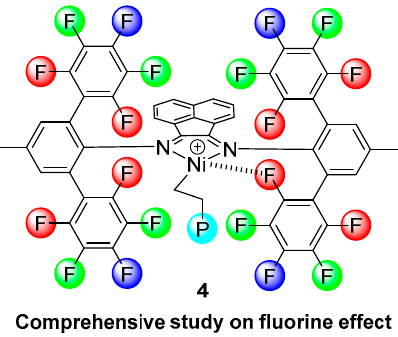
Figure 3. The fluorinated α -diimine Ni(II) catalysts 4 (in the copolymerization of ethylene with polar monomer, the ortho -F substituent is definitely unfavorable for the incorporation, and both the meta -F substituent and the para -F substituent show a slight influence in terms of incorporation). The Gao group synthesized a novel dinaphthobarrelene-based α -diimine Ni catalyst 5 (Figure 4) from the viewpoint of three-dimensional (3D) space for ethylene (co)polymerizations [71], in which the 3D-constrained space around Ni center could lead to enhancement on ther- mal stability, living fashion, and tolerance towards polar groups in copolymerizations of ethylene with bromo-1-olefins and hydroxy-1-olefin. Even at 80 ◦ C, copolymerization of ethylene and 10-undecenol (UOH) was still active to produced copolymer with high incorporation of 5.21 mol%, and the living copolymerization could also be realized below 35 ◦ C, which was one of the rare samples for living copolymerization of ethylene and polar